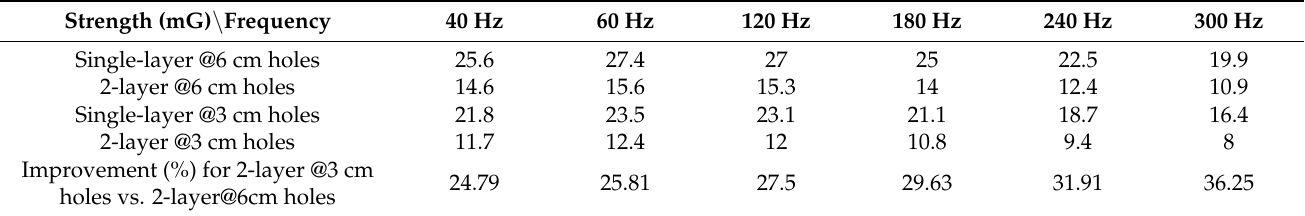
Figure 12. The magnetic strength of the shielding box for the multi-layer structure and different hole patterns. Table 11. The comparisons of shielding capability for the PMCS for the multi-layer structures for the hole sizes of 3 cm and 6